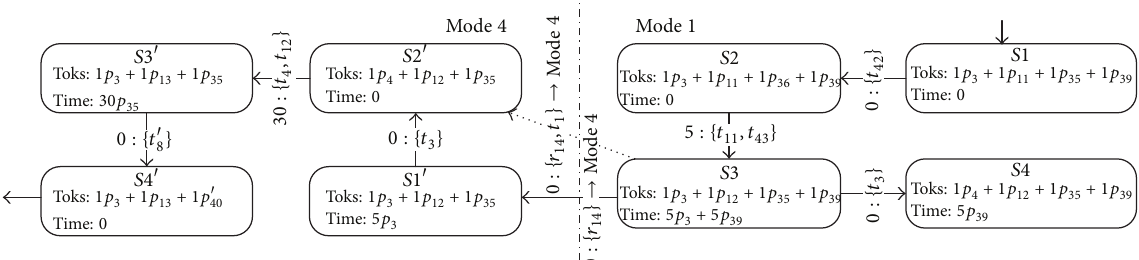
Figure 5: State transition graph of Example 3.